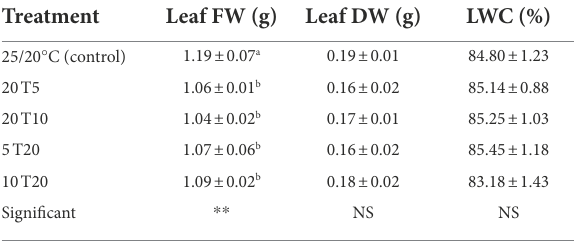
NS indicates no statistical significance. Data are mean ± standard error of four biological replicates. Means within columns were compared using Tukey’s honestly significant difference (HSD). Different letters indicate significant differences within column. The asterisks indicate the significance level ( ** p < 0.01).